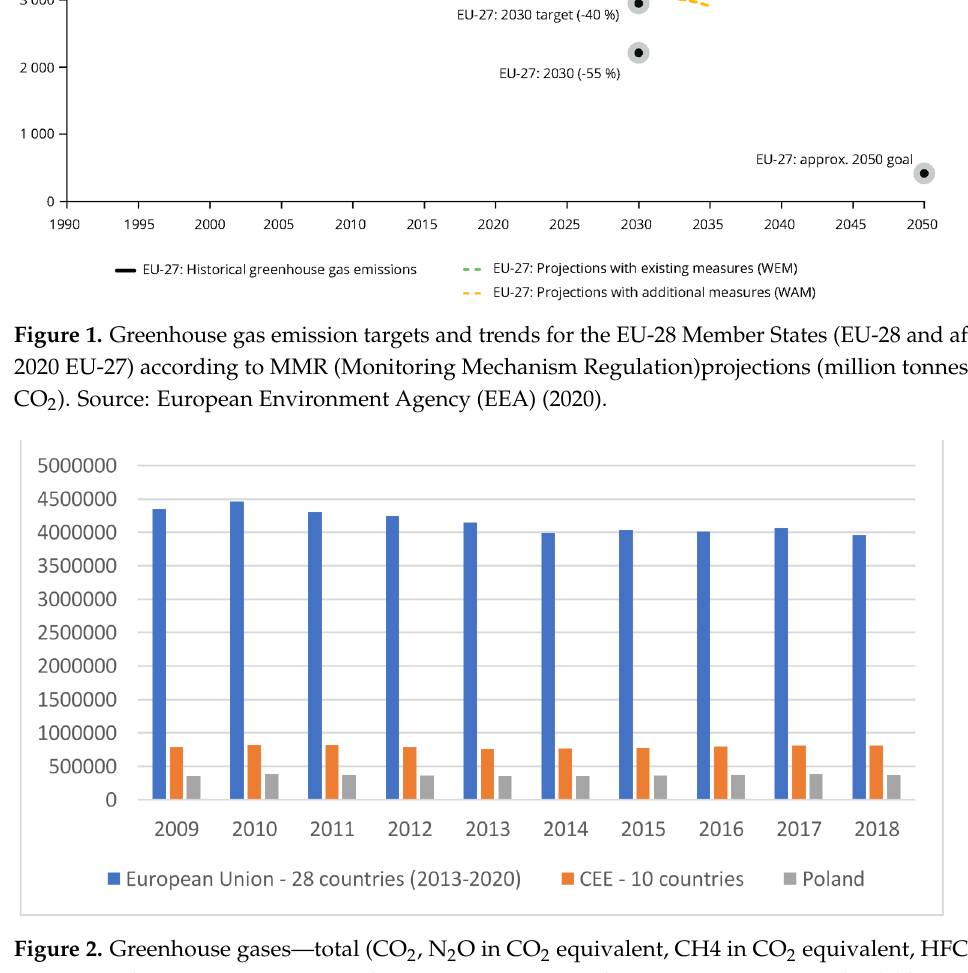
Figure 2. Greenhouse gases—total (CO 2 , N 2 O in CO 2 equivalent, CH4 in CO 2 equivalent, HFC in 97 CO 2 equivalent, PFC in CO 2 equivalent, SF6 in CO 2 equivalent, NF3 in CO 2 equivalent) (thousand 98 tonnes of CO 2 ). Source: Own calculations based on Eurostat database (2020). 99